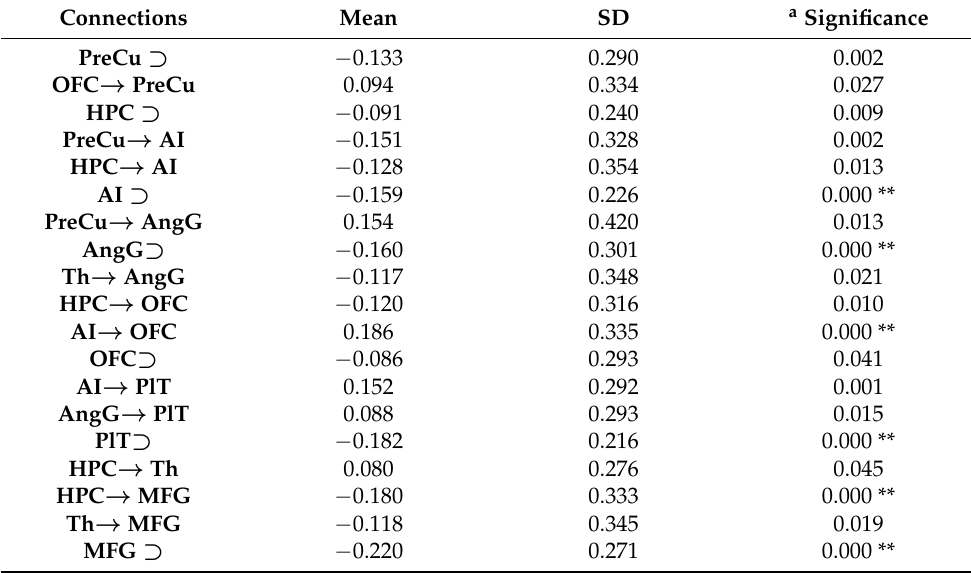
Table 3. Connections significantly different from zero in the whole sample.